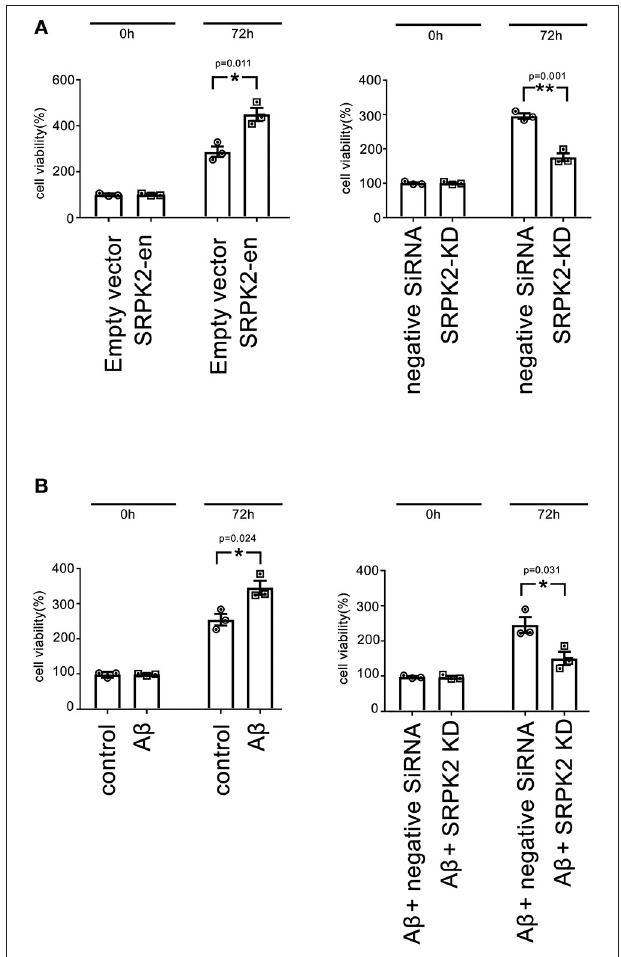
FIGURE 3 | The expression of SRPK2 can promote BV2 cell viability (A) . The BV2 cells with different pretreatments (transfection of SRPK2 recombinant lentiviral vectors or knockdown of SRPK2 by transfection of siRNA) were cultured in vitro for 72h and the cell viability was measured by WST-1 assay. The results showed that the cells with the expression of SRPK2 had higher cell viability rates compared to the controls (empty vector transfection), whereas the knockdown SRPK2 inhibited cell viability compared to that in cells transfected with negative siRNA. (B) β -amyloid (A β ) treatment can promote BV2 cell viability, which can be attenuated by the knockdown of SRPK2. The BV2 cells with/without SRPK2 knockdown were treated with A β as described in the Methods section for 72h and the cell viability was measured by WST-1 assay. The results showed that A β treatment can promote BV2 cell viability compared to the controls (cells treated with DMSO), whereas the proviability effect of A β can be alleviated by knockdown of SRPK2 expression in the BV2 cells. All the results were representative of three independent experiments performed in triplicate. The results were expressed as the mean ± SEM for three replicate determinations (* p < 0.05, ** p < 0.01 by the Student’s t -test). SRPK2-en, transfection increased SRPK2 expression;